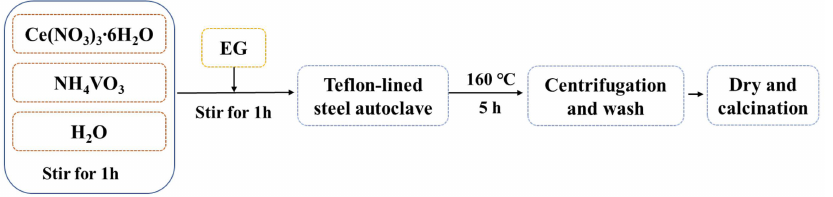
Figure 8. The schematic representation of synthesis of CeVO 4 -V 2 O 3